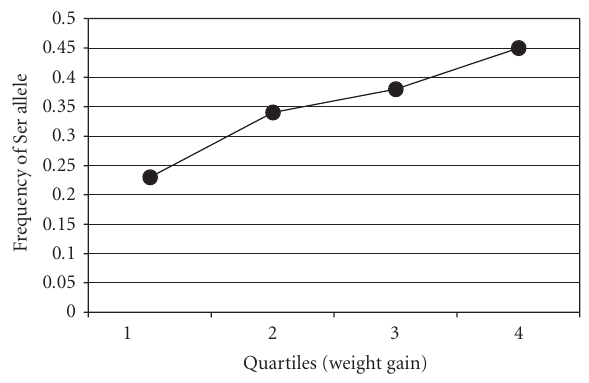
Figure 1: Association of the PPARGC1A Ser 482 allele with weight gain in all quartiles of males with T1DM on intensive diabetes therapy. The frequency of the Ser allele in Q1 ( N = 126) was 0.23; Q2 ( N = 172) was 0.34; Q3 ( N = 158) was 0.38; Q4 ( N = 102) was 0.45. The Ser allele was significantly associated with a trend for higher weight gain with a P -value of .004 (Chi-square with 3 degrees of freedom), and a P -value of .0004 (trend,